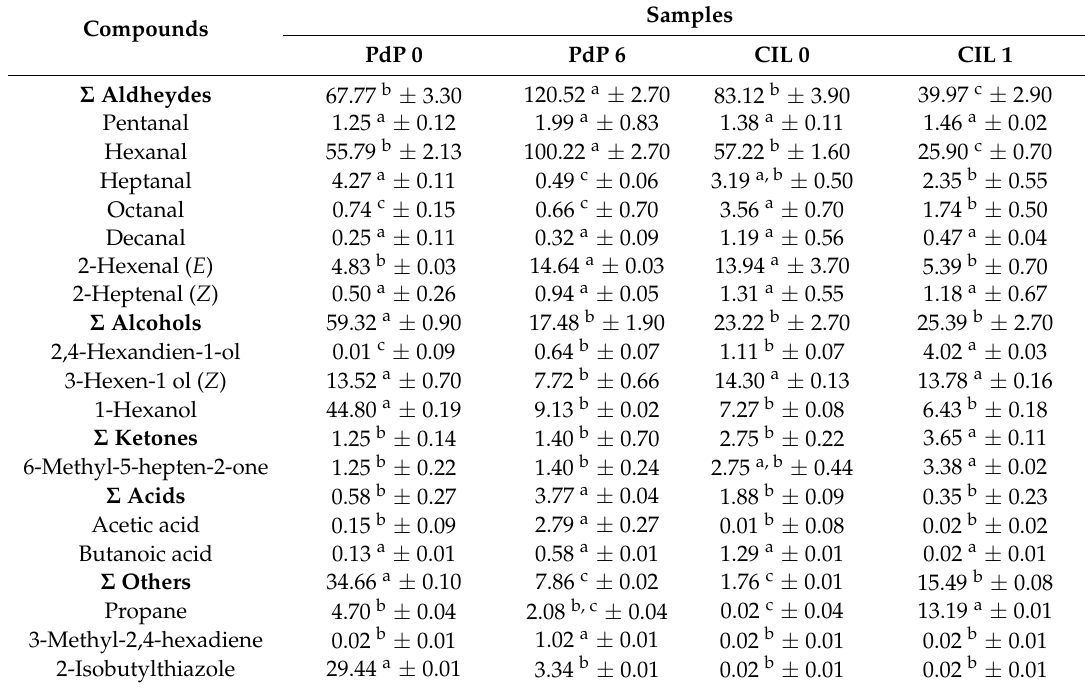
Table 5. VOC (mg/kg of fresh weight ± standard deviation) detected in samples in amount >1%.